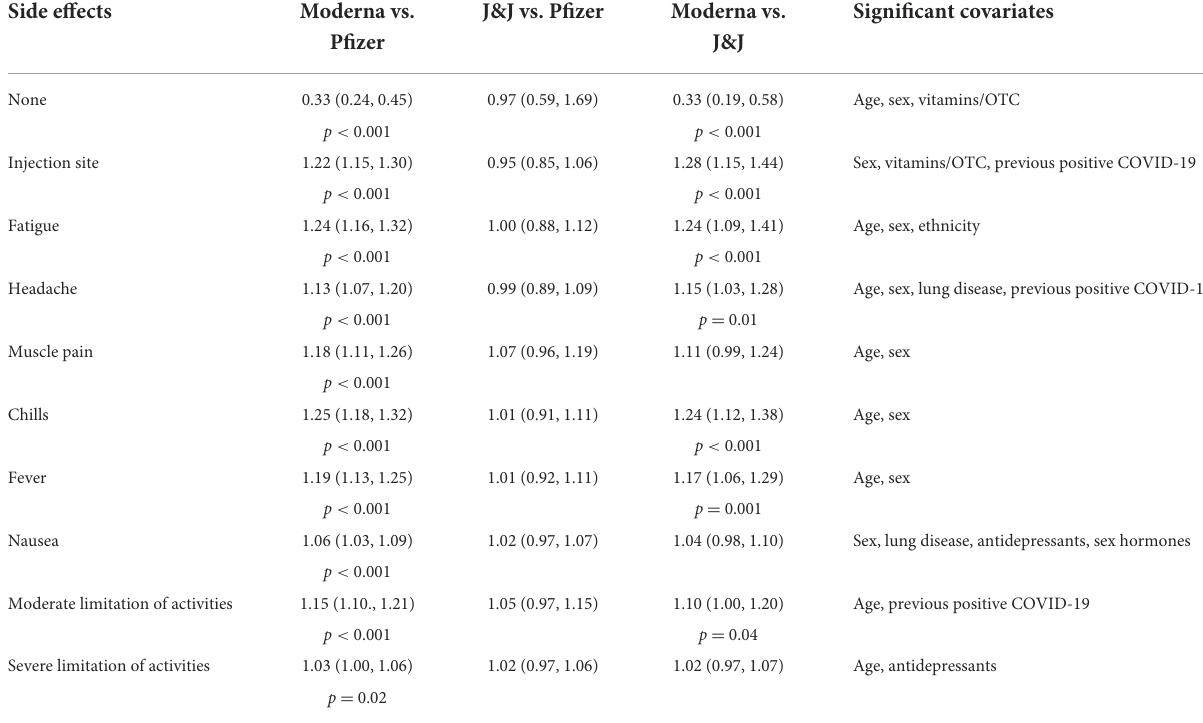
TABLE 4 Multivariate logistic regression models to predict side